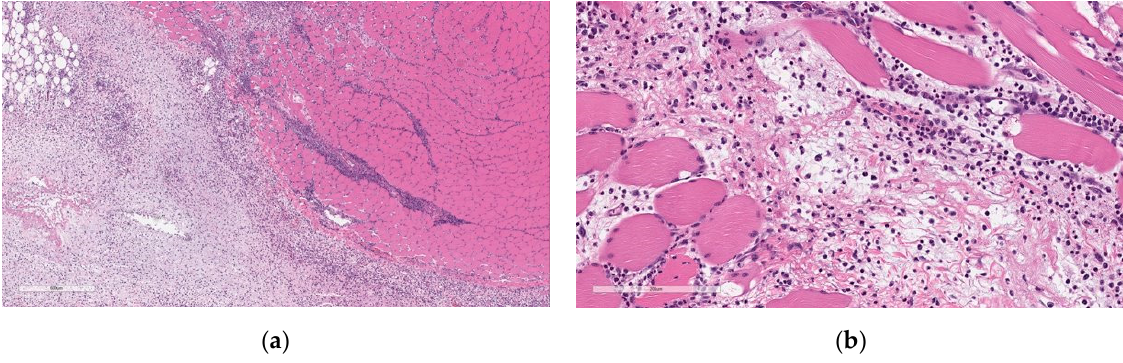
Figure 5. Histopathologic features of Injection site inflammation and edema at the end of the dosing phase. ( a ) Injection site sections of BNT162b2 (V9) treated animals euthanized 2 days after the third dose (Day 17) showed inflammatory cells admixed with abundant pale eosinophilic fluid (edema) infiltrating and expanding subcutaneous tissue and connective tissue of skeletal muscle. ( b ) Higher magnification of ( a ) showing.